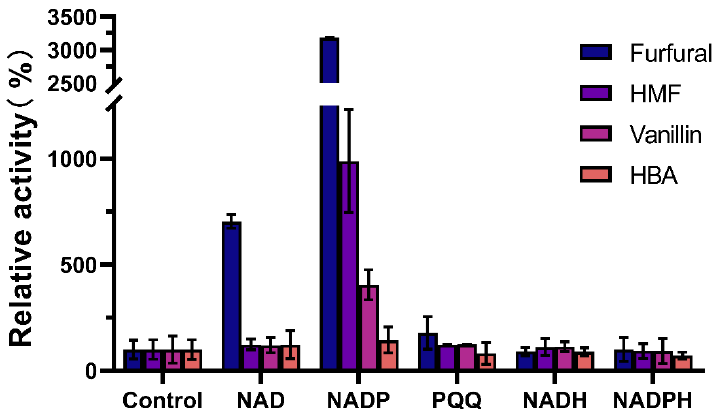
Figure 4. The effect of different cofactors on enzyme activity. Enzyme activity was measured by adding 1 mM NADP, 1 mM NAD, and 1 µM PQQ to the reaction system, respectively. The enzyme activity measured without cofactor was 100%.